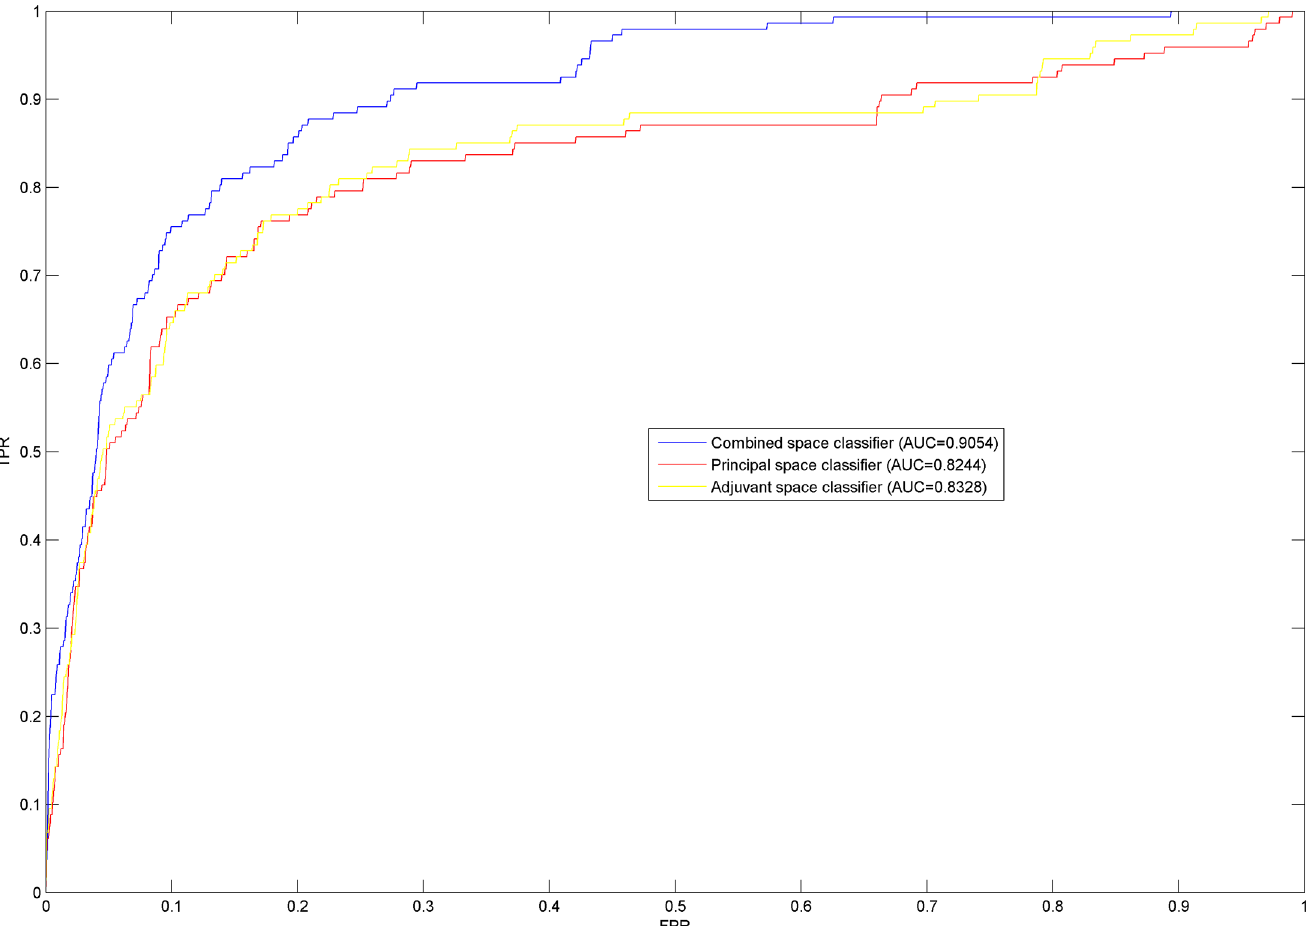
Fig 4. LOOCV was implemented in the antifungal synergistic drug combinations dataset 1. AUC was calculated to evaluate the performance of the method. Here known synergistic drug combinations were used as a test dataset. The ROC curves of NLLSS based on the combination of two classifiers and based only on a single classifier were compared. The results confirmed the performance advantage of combining the classifiers in the principal and adjuvant drug space into a single classifier.